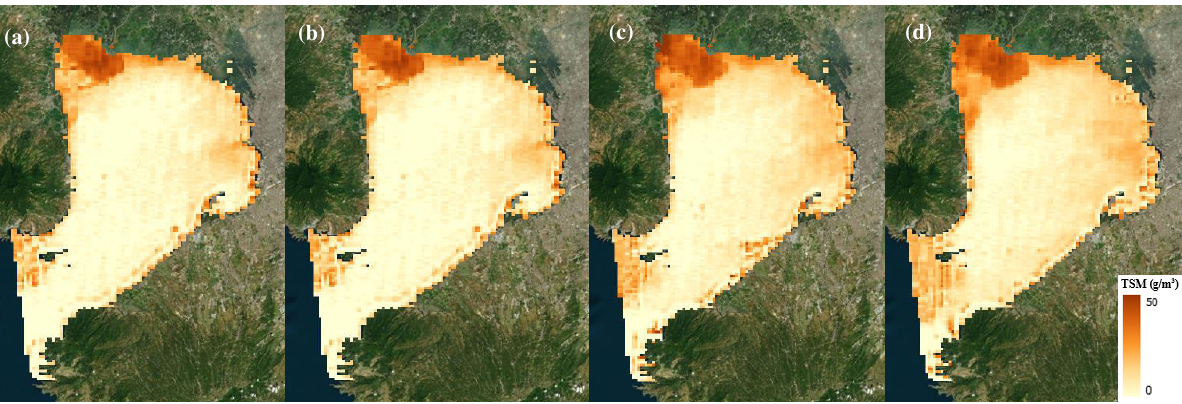
Figure 13. TSM maps for September 26, 2019 using the Wet model: (a) 9:10, (b) 9:30, (c) 9:50, and (d) 10:10 AM In general, high concentration of Chl- a and TSM can be found near the coastal areas of the bay. Specifically highest concentrations can be found in the North-western area of the bay near Pampanga-Bataan province. Higher concentrations can also be observed near the mouths of Guagua River, Pampanga River, and Angat River. Discharges from the river contribute to the increase in concentration of the respective areas. Fishponds and aquaculture can also be found in the area which also contribute to the increase in concentration due to the feeds and nutrients present in the water. Comparitively high concentrations can also be found in the Eastern area of the bay near Metro Manila area. Low concentrations are found in the central and mouth area of the bay which is explained by characteristic of open water being naturally less turbid. For the generated maps for September, the concentrations are higher in the Eastern area compared to maps for